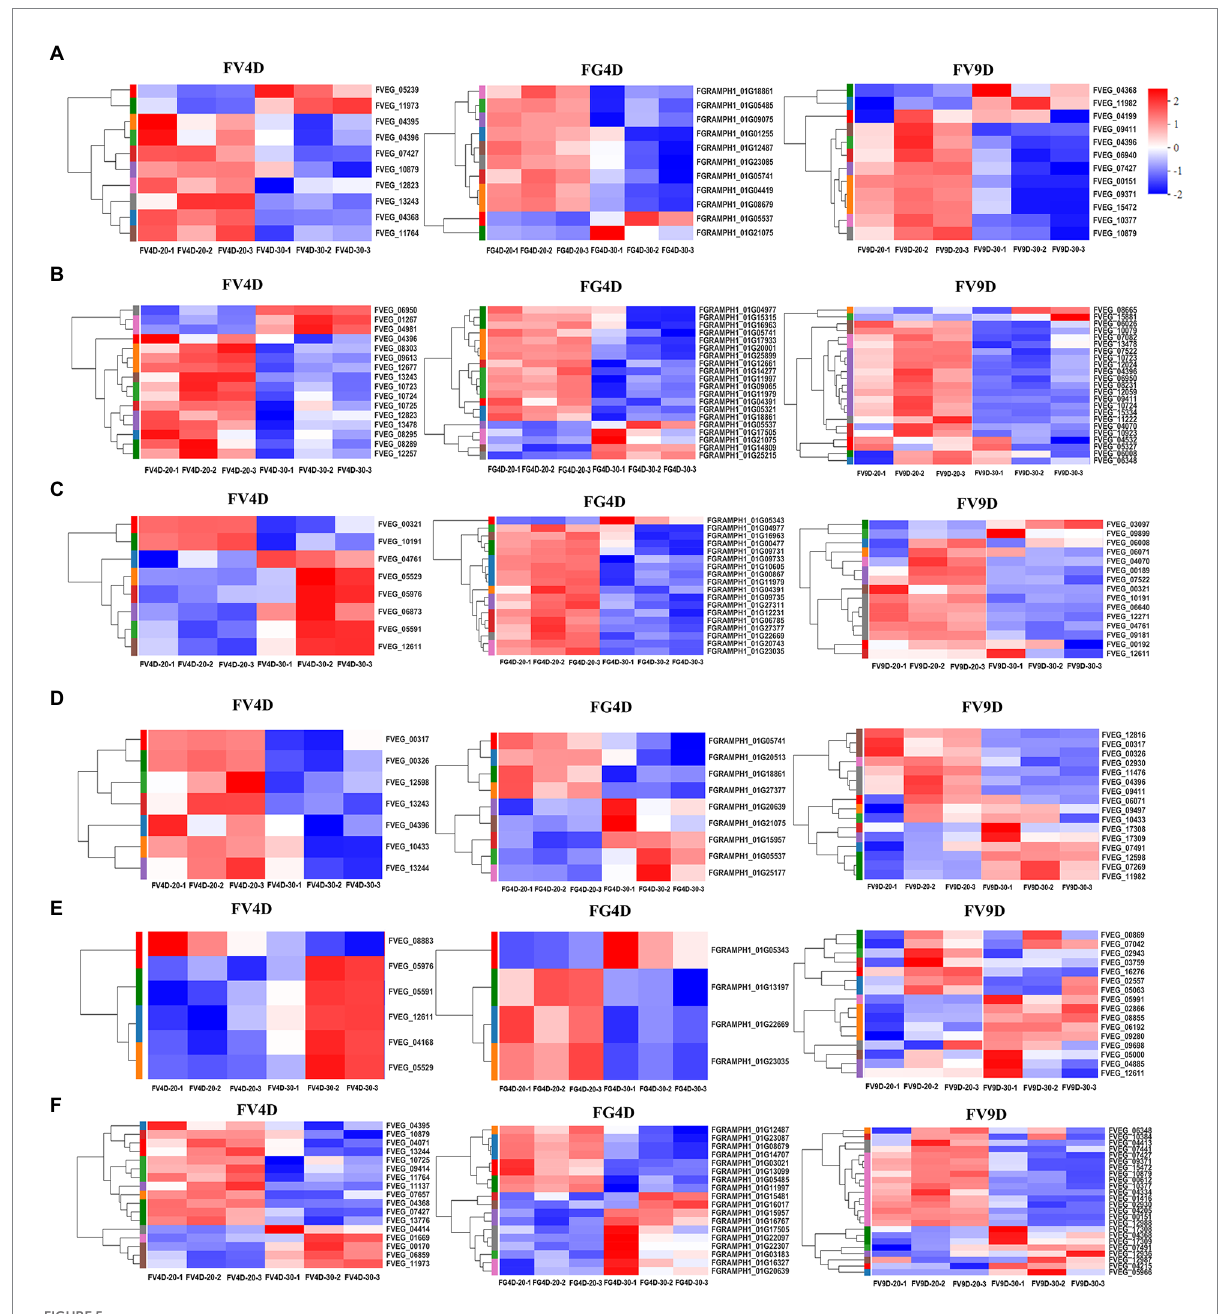
FIGURE 5 Heat map of differently expressed genes enriched in beta-alanine metabolism (A) , Arginine and proline metabolism (B) , Glyoxylate and dicarboxylate metabolism (C) , Fatty acid degradation (D) , MAPK signaling pathway–yeast (E) , Tyrosine metabolism (F) , pathways. Red to blue indicates expression level from high to low. FV4D-20: F. verticillioides cultivated for 4 days at 20 ° C, FV4D-30: F. verticillioides cultivated for 4 days at 30 ° C, FG4D-20: F. graminearum incubated for 4 days at 20 ° C, FG4D-30: F. graminearum cultivated for 4 days at 30 ° C, FV9D-20: F. verticillioides cultivated for 9 days at 20 ° C, FV9D-30: F. verticillioides cultivated for 9 days at 30 ° C. FV4D: DEGs by comparing samples FV4D-20 with samples of FV4D-30. FG4D: DEGs by comparing samples FG4D-20 with samples of FG4D-30. FV9D: DEGs by comparing samples FV9D-20 with samples of